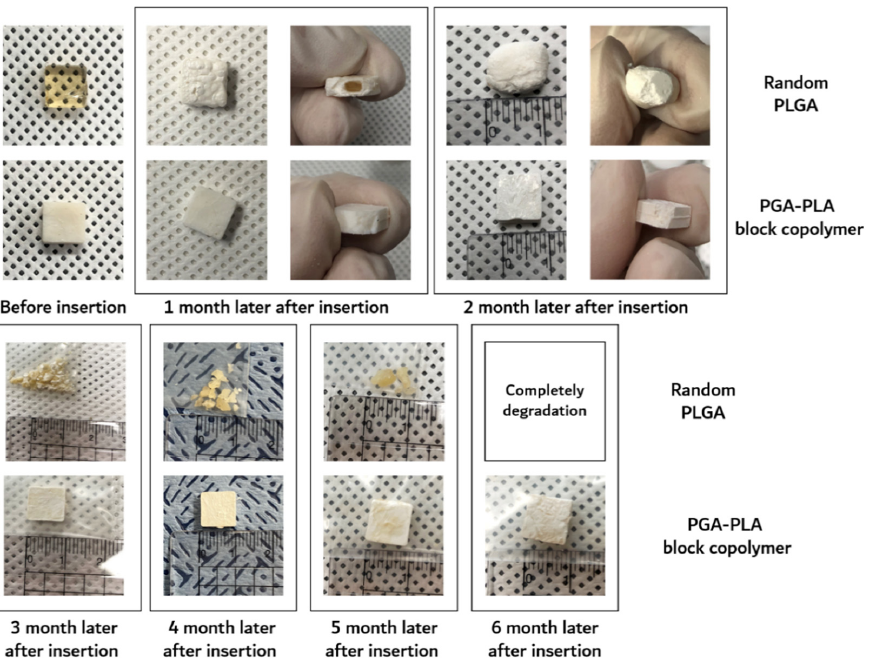
Figure 7. Image of the extracted in vivo animal-degradation-test samples (interval of extraction: 1 month, SD-rat, n = 3).